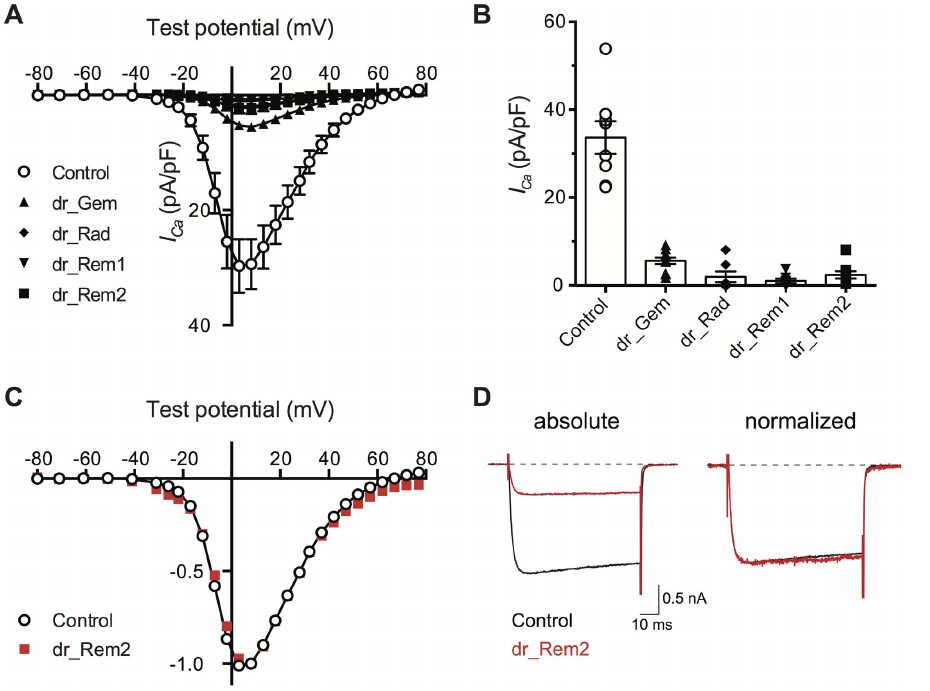
Figure 1. Heterologous expression of zebrafish RGK protein orthologs reduces I Ca density in rat sympathetic neurons. A. Current- voltage ( I-V ) plots in which mean 6 SEM I Ca density (pA/pF) is plotted versus test potential (mV). I Ca was evoked from a holding potential of 2 80 mV to the test potentials indicated. I Ca amplitude, determined 10 ms after initiation of the test pulse, was normalized to membrane capacitance ( C m ). Control neurons (open circles) were injected with EGFP cDNA (n=6). Neurons previously injected with Danio rerio RGK protein cDNA clones (100 ng/ m l approximately 18–24 hours prior to recording) are depicted with filled symbols: dr_Gem (triangle, n=11); dr_Rad (diamond, n=7), dr_Rem1 (inverted triangle, n=7), and dr_Rem2 (square, n=9). B. Category plot of data shown in panel A for I Ca density at + 10 mV. Mean I Ca density for neurons expressing RGK protein clones differed significantly ( P , 0.05) from control (one-way ANOVA followed by Dunnett’s multiple comparisons test). C. Normalized I-V plots for control (open circle) and dr_Rem2 expressing (red filled square) neurons. Data, from panel A, was normalized to the maximal I Ca density and plotted to illustrate similarity of voltage-dependence. D. Exemplar I Ca traces acquired at + 10 mV from control (black) and dr_Rem2 (red) expressing neurons. Traces are depicted without (left) and with normalization (right) to maximal current. Dotted line represents zero current level.